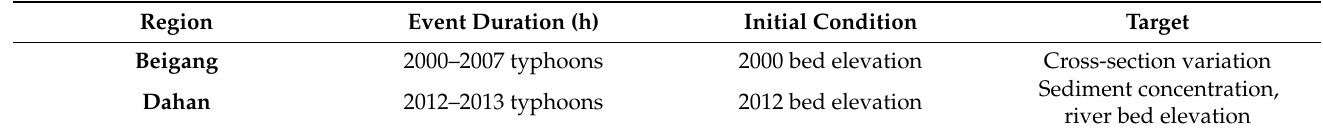
Table 2. Case study